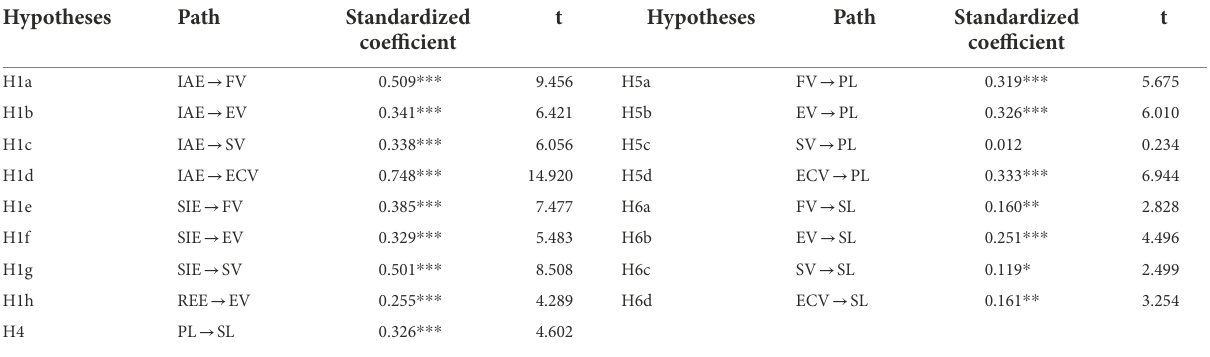
TABLE 7 Test of the main effects and hypotheses.